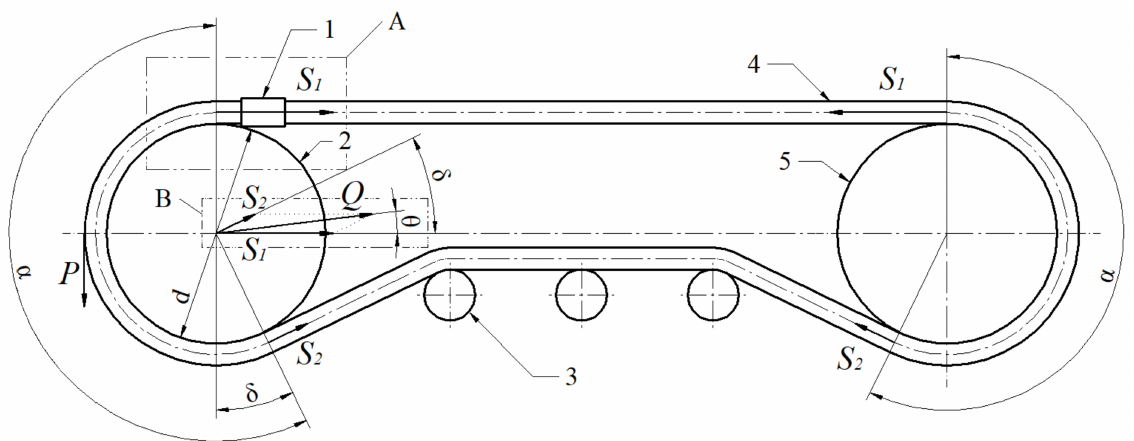
Figure 1. Structural diagram of a belt conveyor with the use of a mechanical connector. Structural description in the text of the article. Other markings: α —angle of contact the roller by the conveyor belt, δ —the lower belt deflection angle, which is the same as the angle between the force vectors in the upper and lower conveyor belt, S 1 —force in the upper band, S 2 —force in the lower band, P —driving force, d —diameter of the roller, θ —angle of deviation of the vector of the resultant force loading the shaft. (Detail A and Detail B are shown in the following